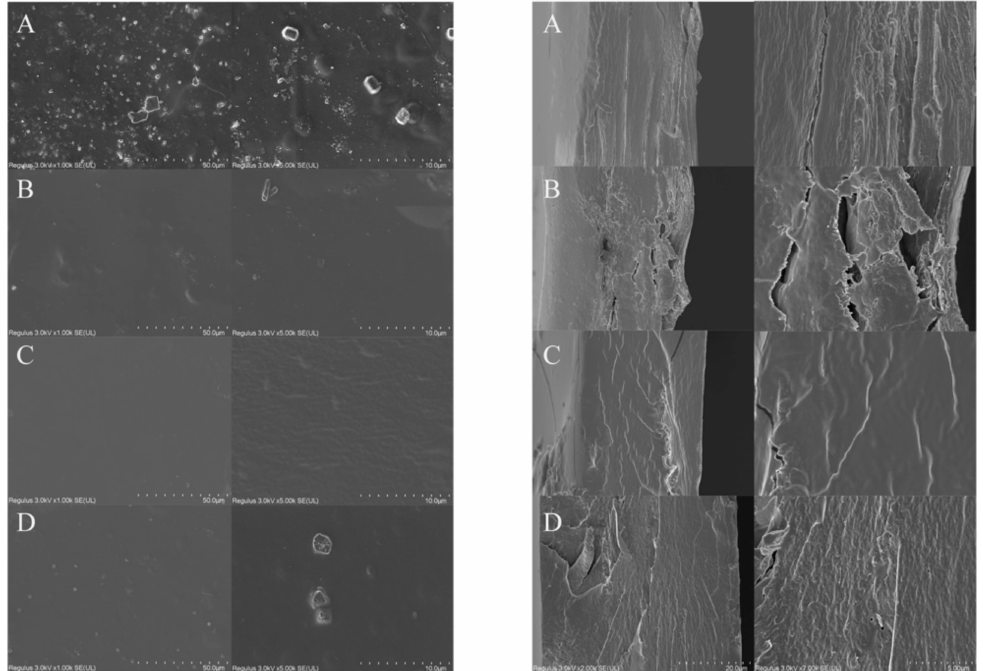
Figure 3. SEM images of the film surface ( left ) and cross section ( right ): ( A ) KGM (KGM 1%) film, ( B ) KGM/SL (KGM 1%, SL 0.2%) film, ( C ) KGM/ ε -PL (KGM 1%, ε -PL 0.375%) film, ( D ) KGM/SL/ ε -PL (KGM 1%, SL 0.2%, ε -PL 0.375%)